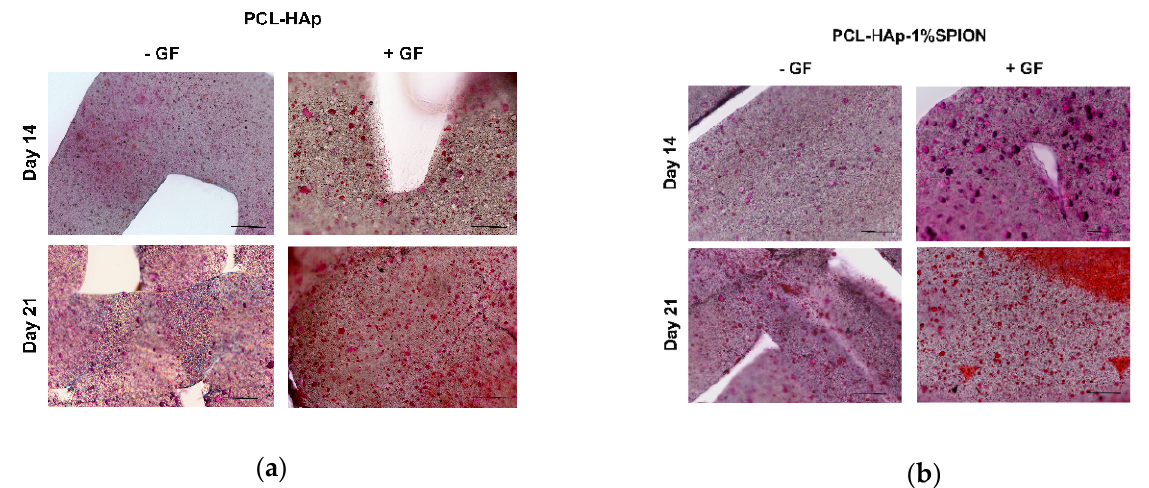
Figure 5. ( a ) Micrographs of PCL-HAp group, cultivated with and without GF (+/ − GF), stained with Alizarin Red-S at 14 and 21 days. Scale bar: 100 µm. Red: mineralized areas. ( b ) Micrographs of PCL-HAp-1% SPION group, cultured with and without GF (+/ − GF), stained with Alizarin Red-S on days 14 and 21. Scale bar: 100 µm. Red: mineralized areas.